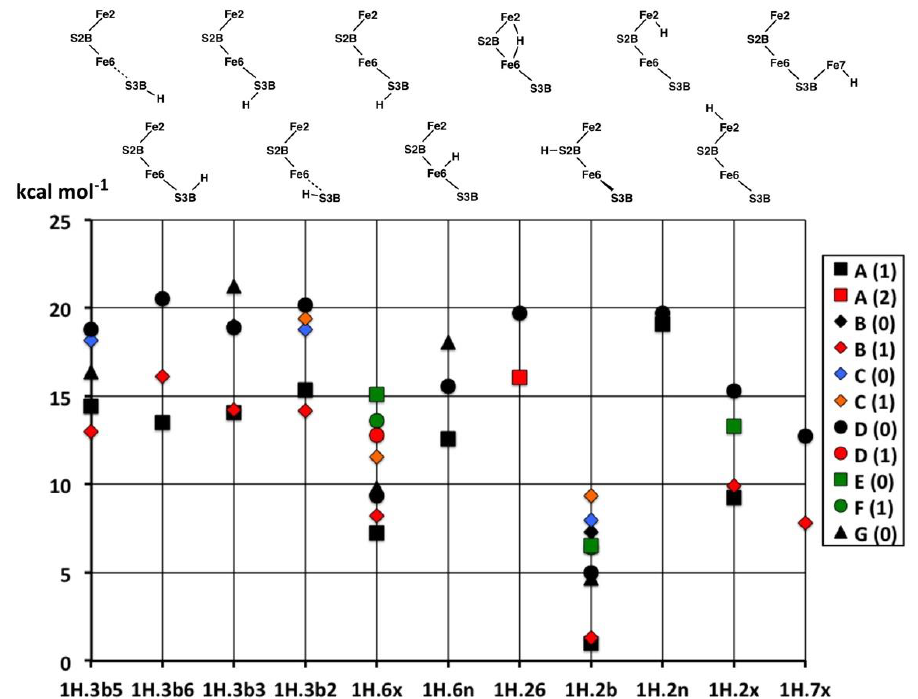
Figure 4. The relative potential energies (kcal mol − 1 ) of the optimised structures with one H atom bonded to FeMo-co, in their most stable electronic/spin states. There are several overlapping symbols.